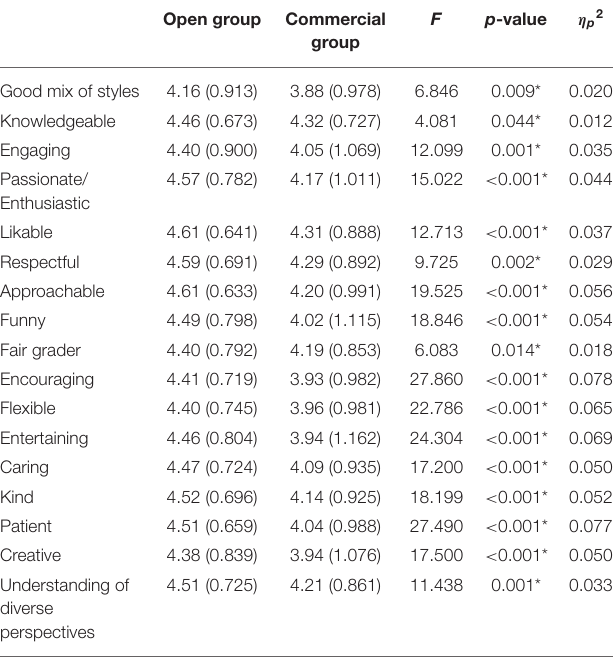
TABLE 2 | Differences in instructor perceptions across textbook